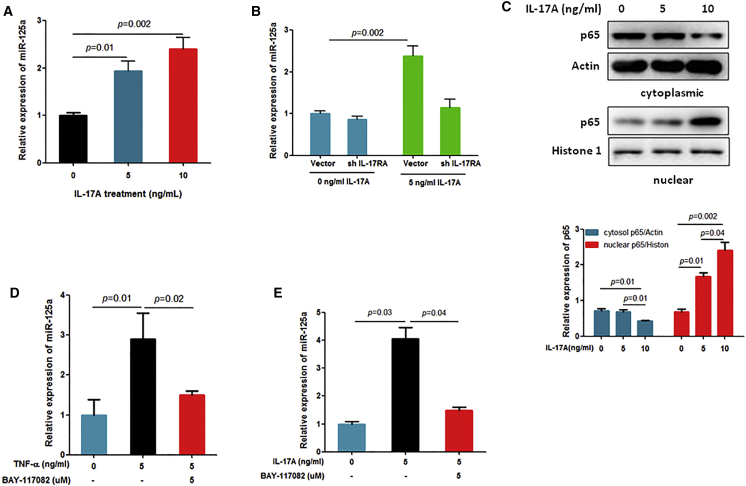
IL-17A Stimulates miR-125a Expression in Stromal Cells by Activating NF-κB Signaling(A) Stromal cells were treated with the indicated concentration of IL-17A for 24 hr, and then the cells were subjected to qRT-PCR analysis to detect the miR-125a expression level. (B) Stromal cells were transfected with the scramble vector or IL-17RA shRNA expressing lentiviral vector, treated with 5 ng/mL IL-17A for 24 hr, and subjected to qRT-PCR to detect the miR-125a expression level. (C) Stromal cells were treated with the indicated concentration of IL-17A for 24 hr, and then we isolated cytoplasmic and nuclear proteins to detect the p65 protein level by western blot analysis. (D) The stromal cells were treated with 5 ng/mL TNF-α with or without 5 μM BAY-117082 for 6 hr. Total RNA was harvested, and miR-125a expression was measured by real-time RT-PCR. (E) Stromal cells were treated with 5 ng/mL IL-17A with or without 5 μM BAY-117082 for 6 hr. Total RNA was harvested, and miR-125a expression was measured by real-time RT-PCR.